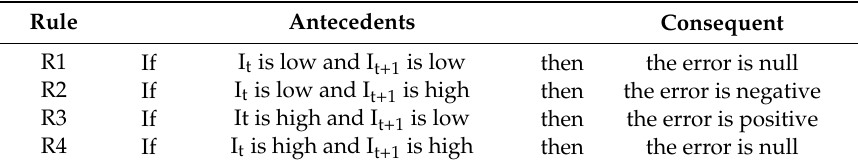
Table 5. Action rules in knowledge base (KB) error.